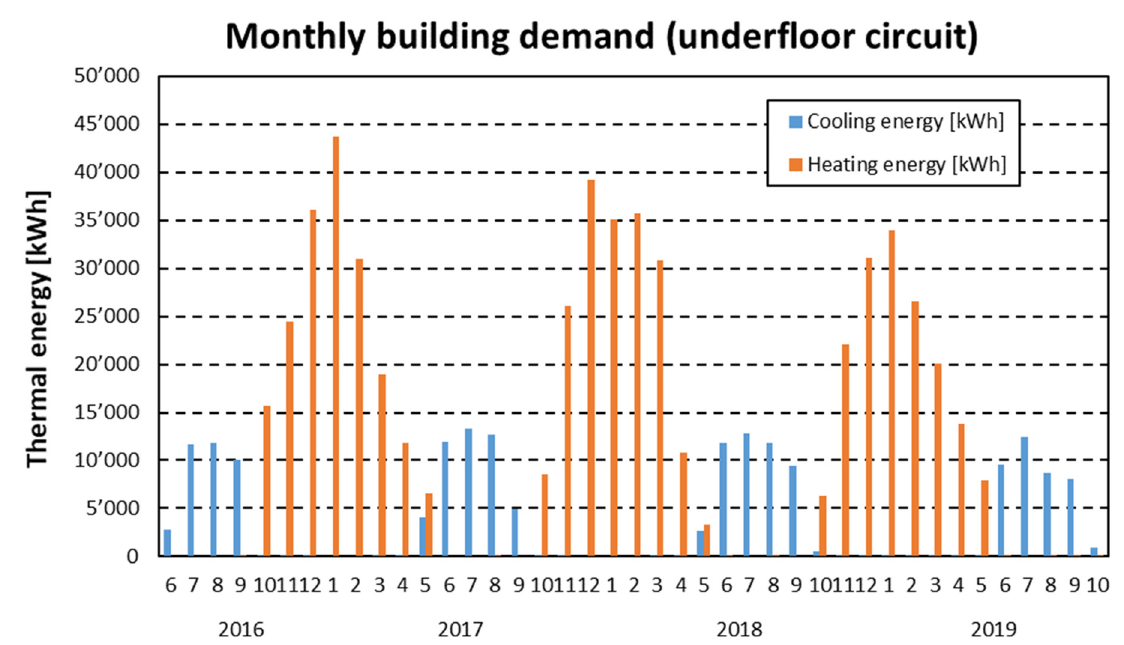
Figure 6. Monthly values of the energy demands (at the heat meter “Q4”) during the monitoring (years and months in the abscissa labels; source: [22]). This measure is called demand to differentiate it from the thermal needs at envelope level.